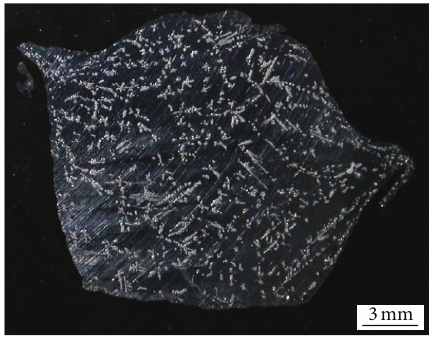
Figure 5: Macrostructure of Sn2La solder